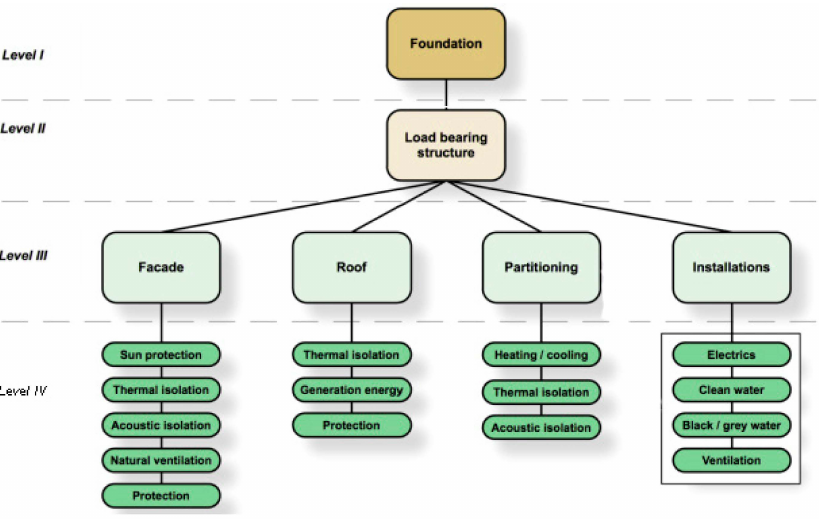
Figure 4. Schematic view for systematic approach according to independent functional and technical levels, IBM massive structure hierarchy